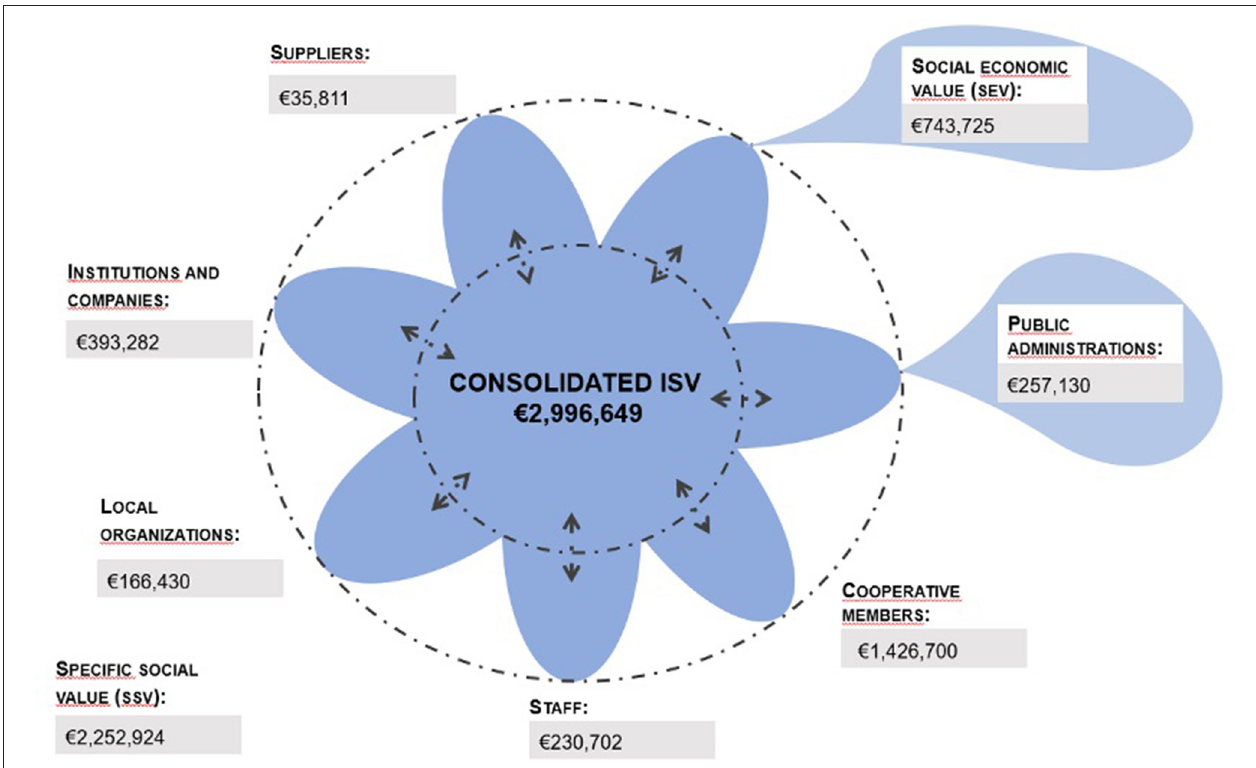
FIGURE 2 | Distribution of the consolidated ISV by stakeholders. Source: Authors’